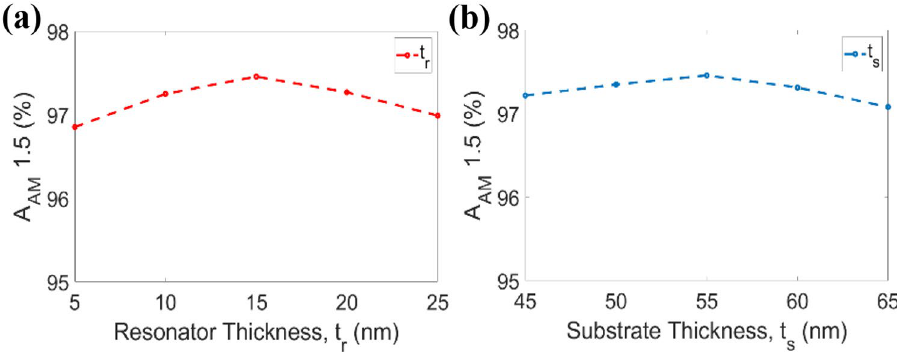
Figure 4. Performance of global standard spectrum in terms of ( a ) resonator thickness tr and ( b ) substrate thickness ts.